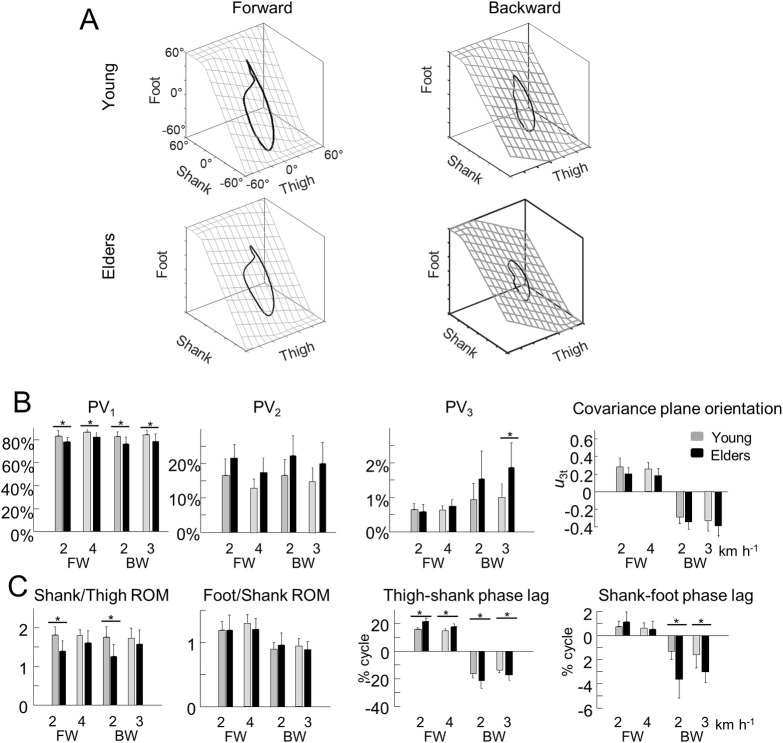
Planar covariation of elevation angles.A–Covariation of the ensemble-average limb-segment elevation angles during forward (right—1.11 m s−1) and backward (left– 3 km h-1) walking in young (up) and older adults (bottom). Note that when the elevation angles of thigh, shank and foot are plotted one versus the other in a x-y-z space, they co-vary along a loop constrained on a plane (x–y). Grids show the best-fitting plane. B–Average percentage of variance accounted for by the first (left—PV1), second (middle—PV2) and third (right–PV3) eigenvector of the principal component analysis and the direction cosines of the normal to the covariation plane with the positive semi-axis of the thigh angular coordinates (u3t). C–Average amplitude ratios between the range of motion of adjacent segments and phase lags between time curves of elevation angles of adjacent segments. In panel A and B, grey bars correspond to young adults, whereas black bars correspond to older adults. The * indicates a significant effect of age.